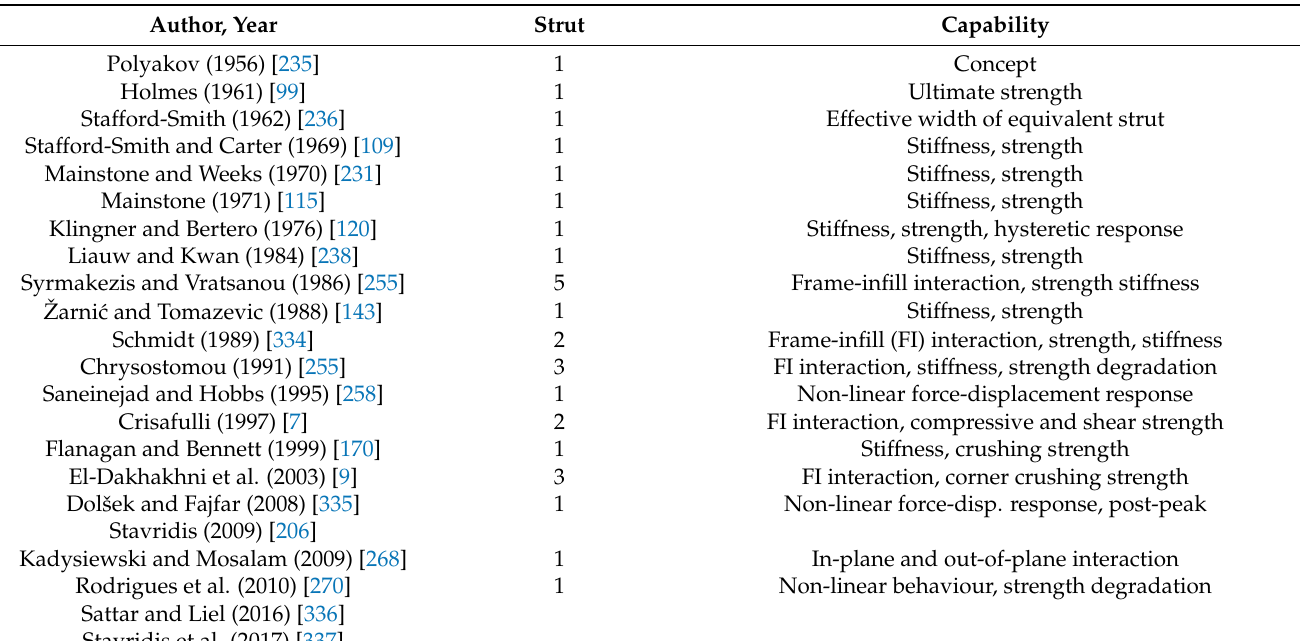
Table 9. Summary of